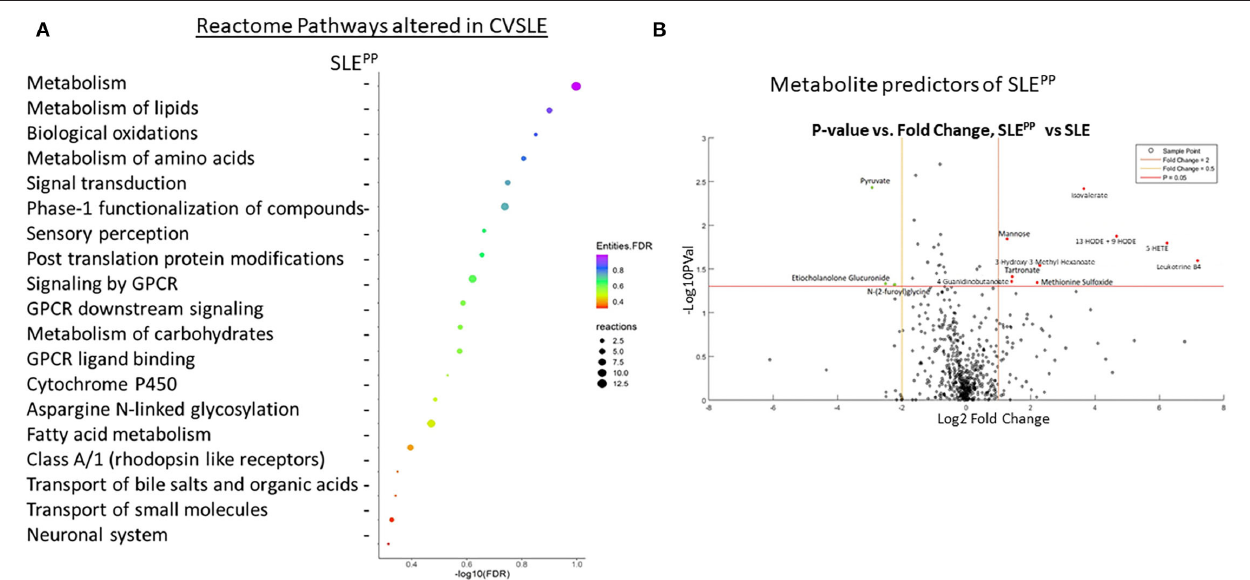
FIGURE 1 | Functional pathways and molecules from serum metabolomics that best discriminate between SLE PP and SLE patients include leukotriene metabolites, which are elevated in SLE PP , and plasmalogen metabolites, which are decreased in SLE PP . Baseline sera from SLE patients who did not develop atherosclerotic plaques, and SLE patients who later developed plaques (“SLE PP ”) were subjected to comprehensive metabolomics, employing LC/MS. Shown in (A) are the metabolic pathways that included molecules significantly increased ( p < 0.05) in the sera of SLE PP vs. SLE patients, as determined by Reactome pathway analysis. For each pathway listed on the y-axis, the negative log base 10 of the false discovery rate is plotted on the x-axis. Dot colors correspond to the value of the inverse common log of the false discovery rate. Dot sizes correspond to “reactions”, or the degree of overlap between molecules of the pathway and molecules that were significantly elevated in SLE PP sera as compared to SLE sera in the metabolomic screen. Pathways with the greatest proportion of molecules elevated in SLE PP sera include metabolism of proteins, post-translational protein modification, and asparagine N-linked glycosylation. Pathways with the lowest false discovery rates included metabolism of lipids, biological oxidations, metabolism of amino acids and derivatives, signal transduction, and metabolism of proteins. Shown in (B) is a volcano plot of the most promising molecules from the metabolomic scan. Molecules represented in green were found to be decreased in concentration in SLE PP vs SLE sera, molecules in red dots were elevated, and black molecules were not significantly altered. Among the serum metabolites found to be significantly elevated ( p < 0.05 and fold change > 2) in SLE PP sera were leukotriene B4 (LTB4), 5-HETE, 13-HODE and 9-HODE, isovalerate, methionine sulfoxide, 3-hydroxy-3-methyl hexanoate, tartronate, 4-guanidinobutanoate, and mannose. Molecules that were decreased ( p < 0.05 and fold change < 0.5) in SLE PP sera included pyruvate, etiocholanolone glucuronide, and